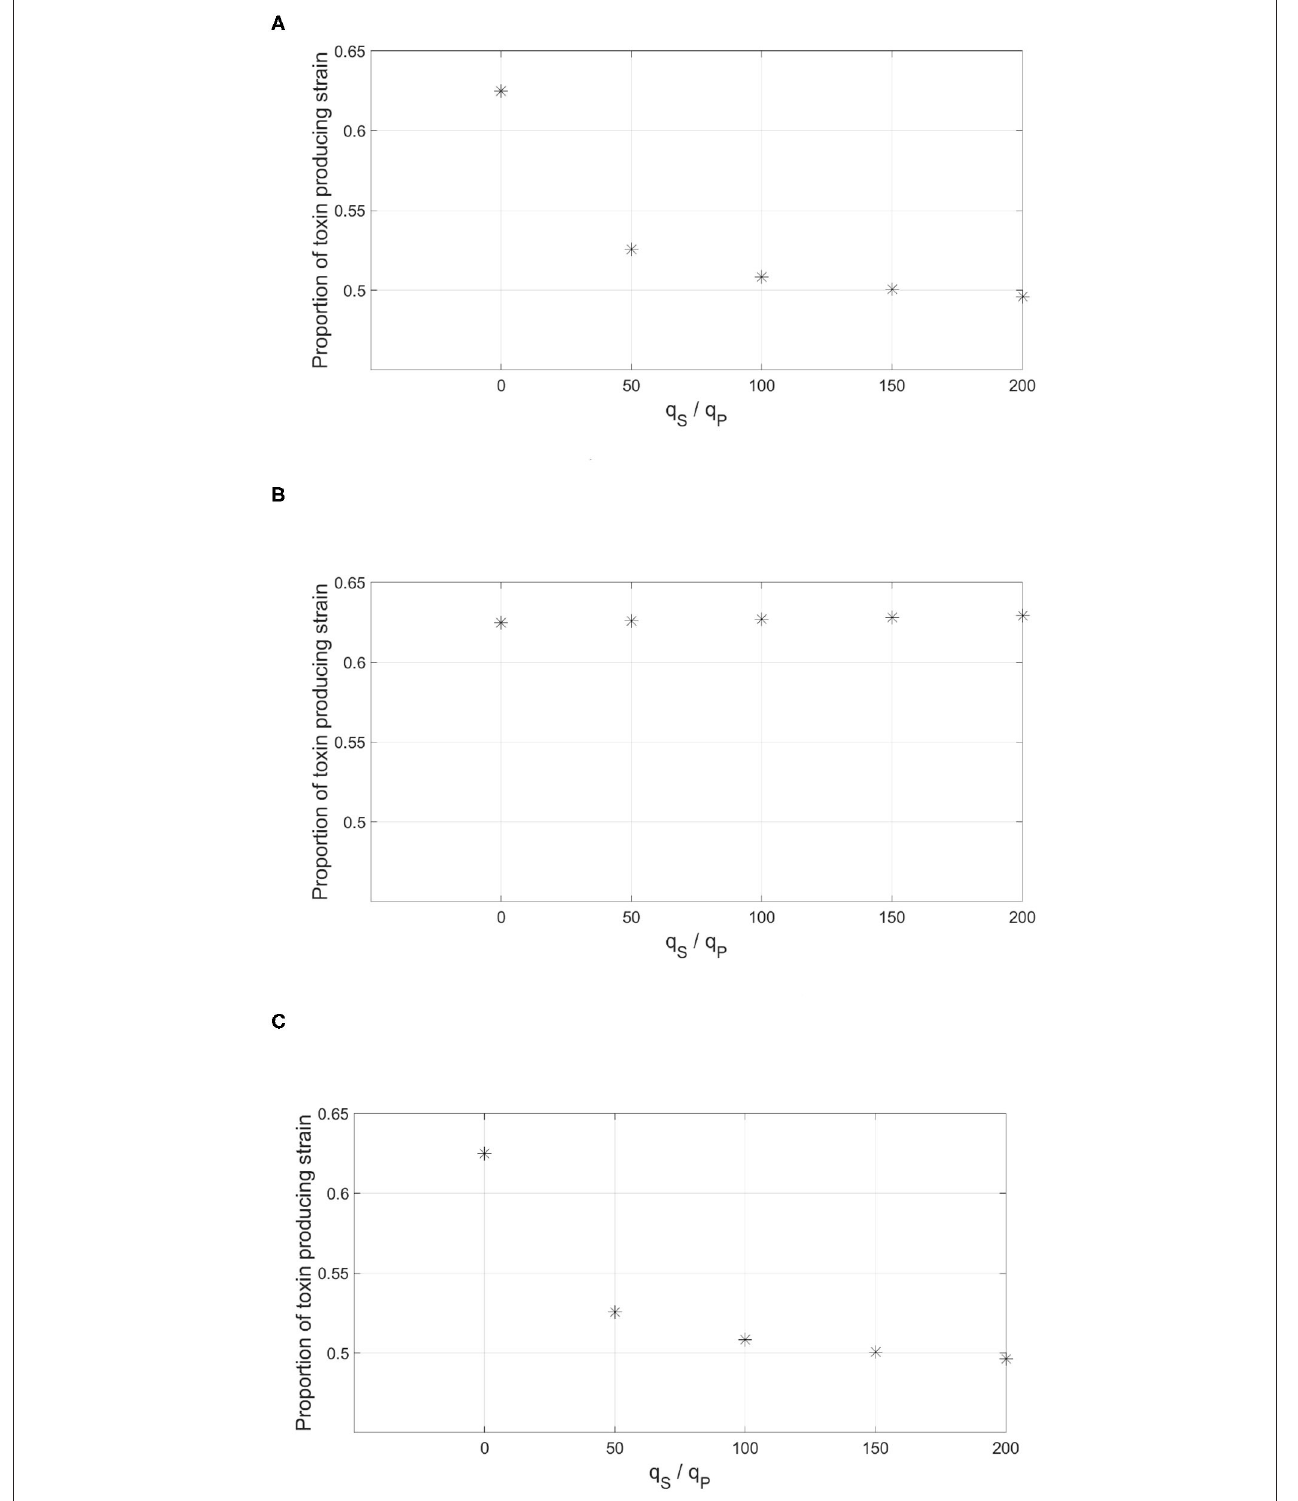
FIGURE 10 | The effect of having multiple QS circuits to regulate the expression of the toxin by the focal strain. The figure depicts the proportion of the focal toxin producing strain by the end of the simulation against increasing levels of dishonest signaling from the sensitive strain on one of the signals. The information from the two parallel QS circuits by the focal strain are combined either in an (A) “OR” gate: the expression of the trait happens when any of the two signals crosses a threshold concentration. (B) “AND” gate: the expression of the trait requires that both signals cross their corresponding threshold concentrations. (C) Weighted sum: both signals contribute equally to the expression of the